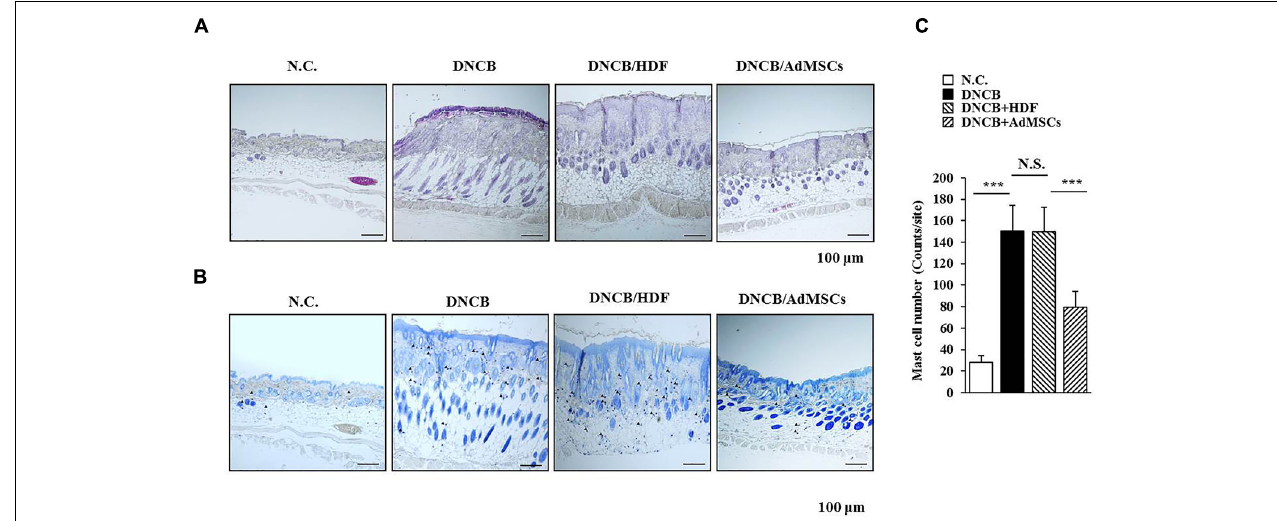
FIGURE 2 | AdMSCs inhibit features of AD. (A) Skin tissues of BALB/c mice of each experimental group were isolated at the time of sacrifice and were subjected to hematoxylin & eosin (H&E) staining. (B,C) Same as (A) except that toluidine blue staining was performed to determine the number of degranulated mast cells. ∗∗∗ p < 0.0005. Closed triangle represents degranulated mast cells. Scale bars represent 100 µ m.